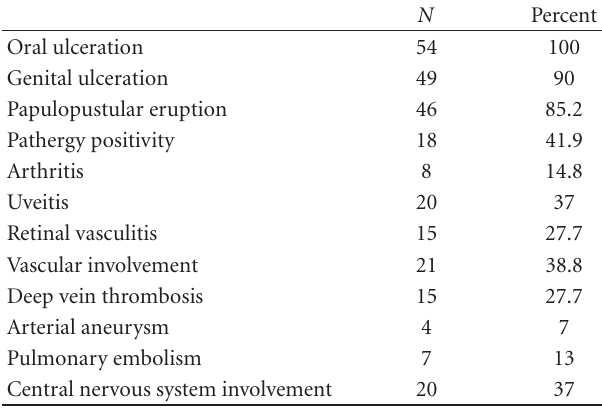
Table 3: Serum homocysteine concentration.